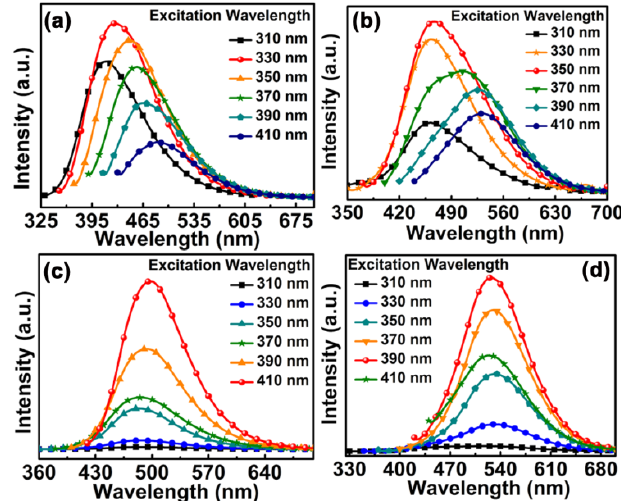
Figure 2. PL spectra of ( a ) CDs-COOH, ( b ) S1, ( c ) S2, and ( d ) S3 excited with different